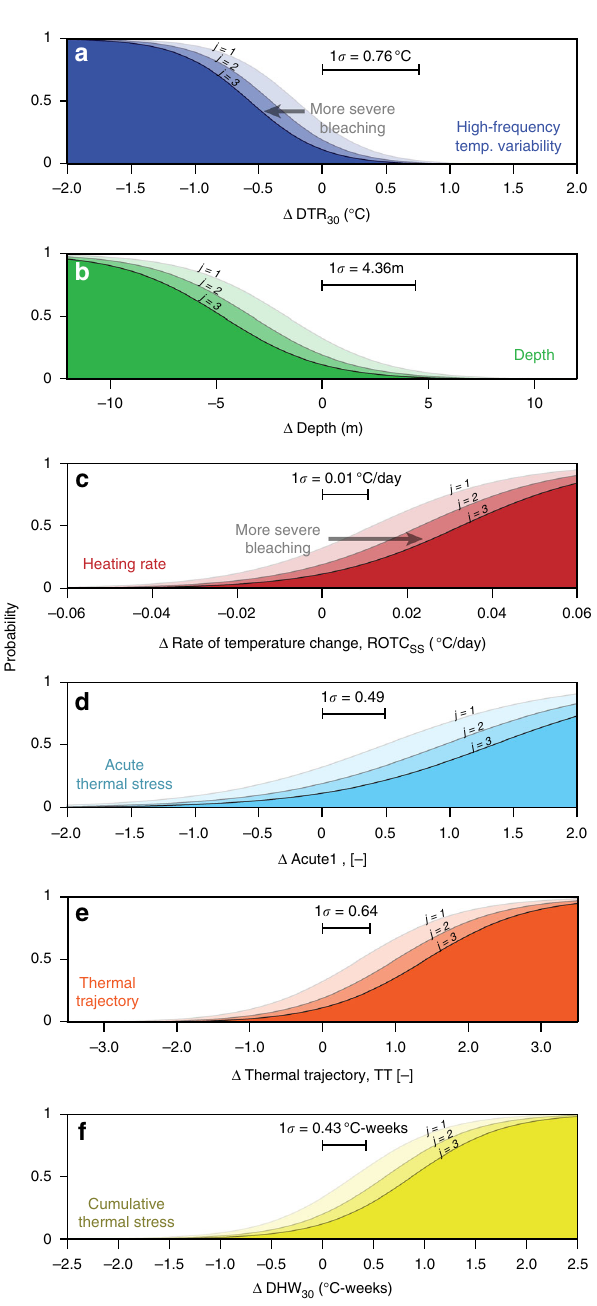
Fig. 4 In fl uence of each in situ covariate on bleaching. Using the covariates from the highest-ranked logit model, the probability of observing bleaching prevalence greater than the j th category is plotted against changes in each covariate from their respective mean values (where 0 corresponds to the mean value), while keeping all other covariates at their mean values. Bleaching prevalence categories are de fi ned as 1: ≤ 10%; 2: 10 − 25%; 3: 25 − 50%; 4: >50% of reef area bleached. Highest-ranked model covariates include: ( a ) High-frequency temperature variability (DTR 30 ), ( b ) Depth, ( c ) Heating Rate (ROTC SS ), ( d ) Acute Thermal Stress (Acute1), ( e ) Thermal Trajectory (TT), and ( f ) Cumulative Thermal Stress (DHW 30 ). Standard deviations for each covariate within our data set are also SST-based OLR models indicate that upon consideration of the consistent importance of DTR to bleaching, a globally available remotely sensed metric for diurnal temperature variability would be valuable for improved bleaching predictions.